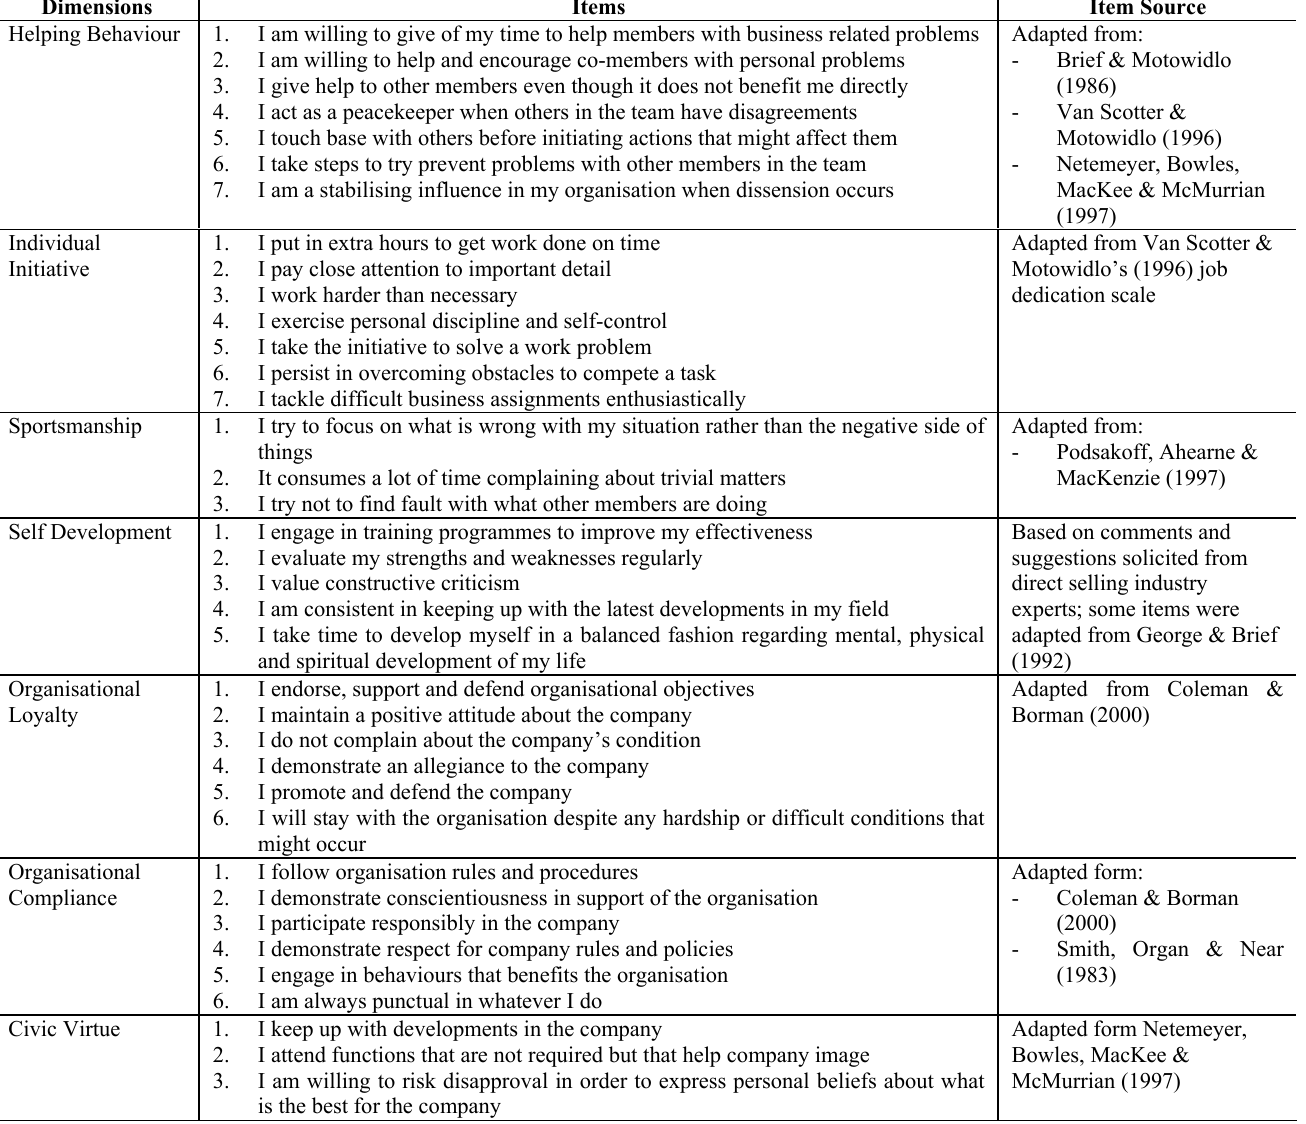
Table 1: Extra-role performance – Items and item source Dimensions Items Helping